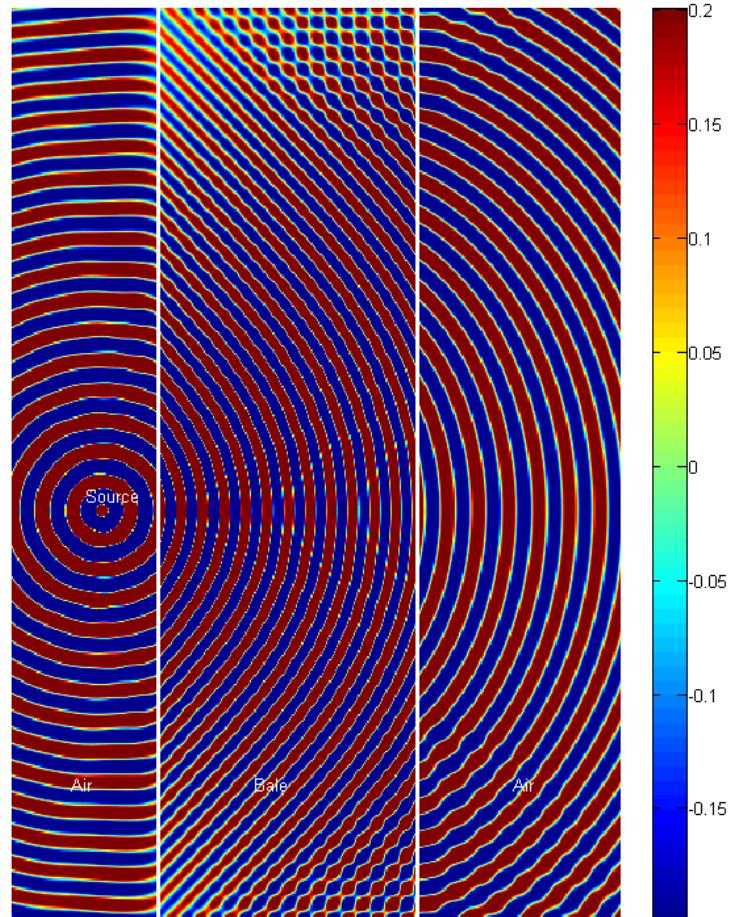
Figure 7. FDTD simulation result illustrating the advancing wave-fronts, as they propagate from left to right, in a bale without metal